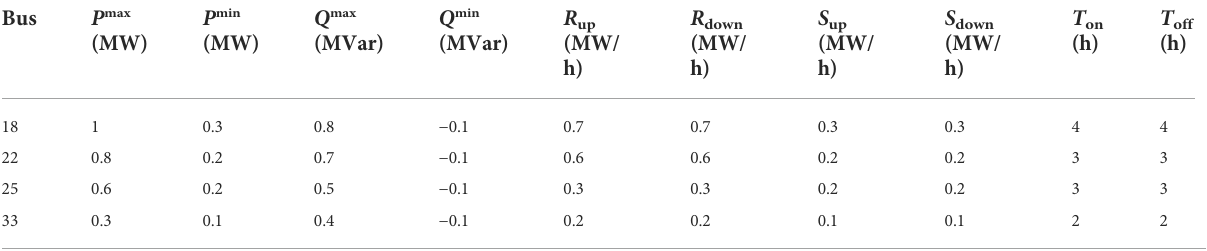
TABLE 1 The operation parameters of power plants.